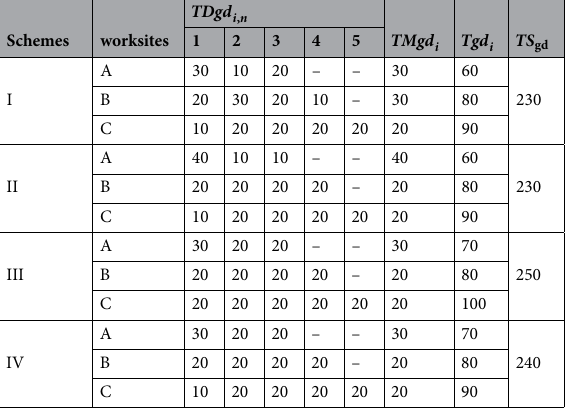
Table 1. Waiting time corresponding to different schemes (unit: